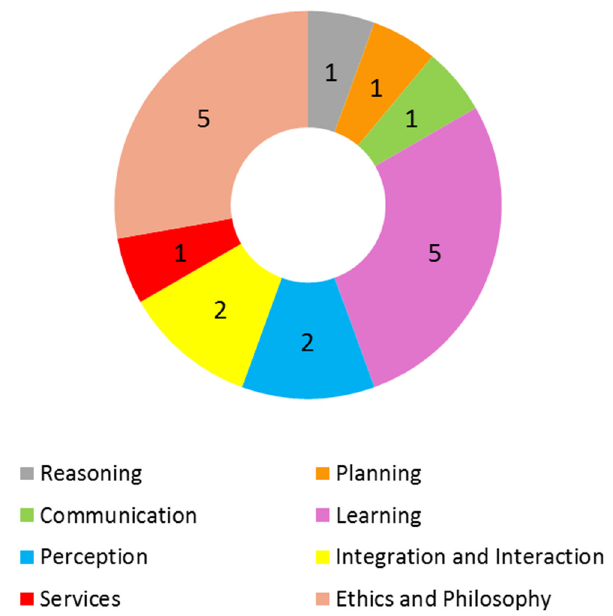
Figure 1. Distribution of the papers in the Special Issue by AI domain of research.